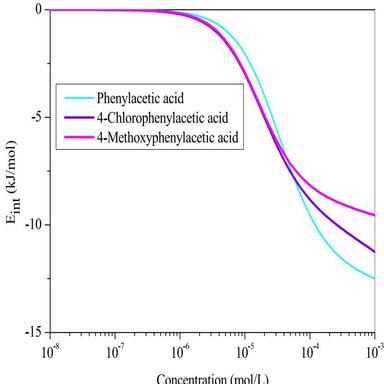
Evolution of the internal energy according to phenylacetic acid, 4-chlorophenylacetic acid, and 4-methoxyphenylacetic acid concentration.